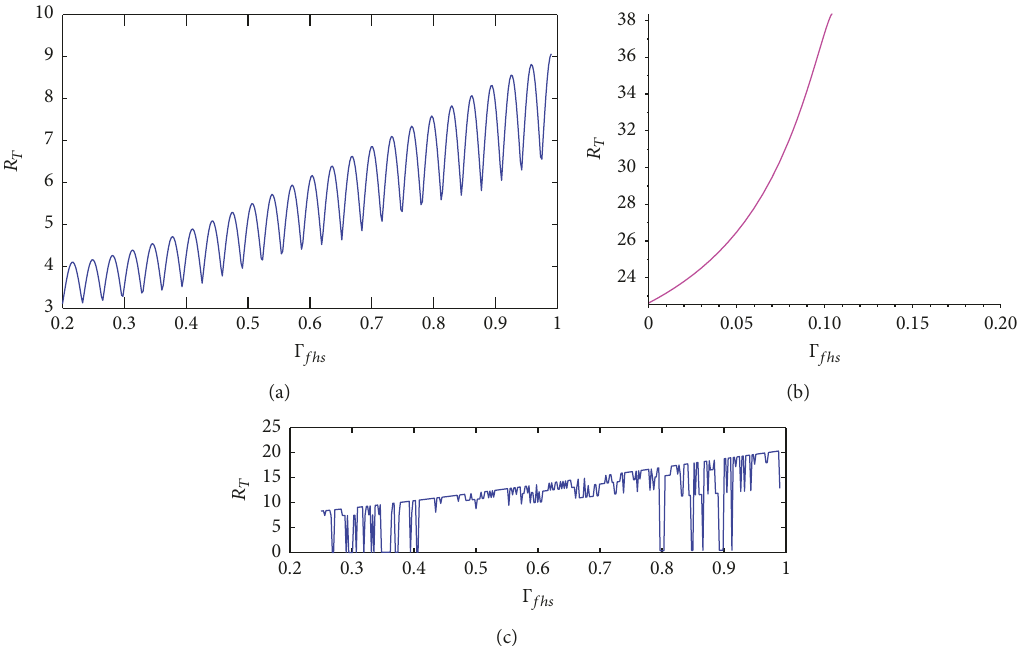
Figure 4: The effect of infection from 𝐼 𝐹 to human beings with septicemic plague on the periodic reproduction number.